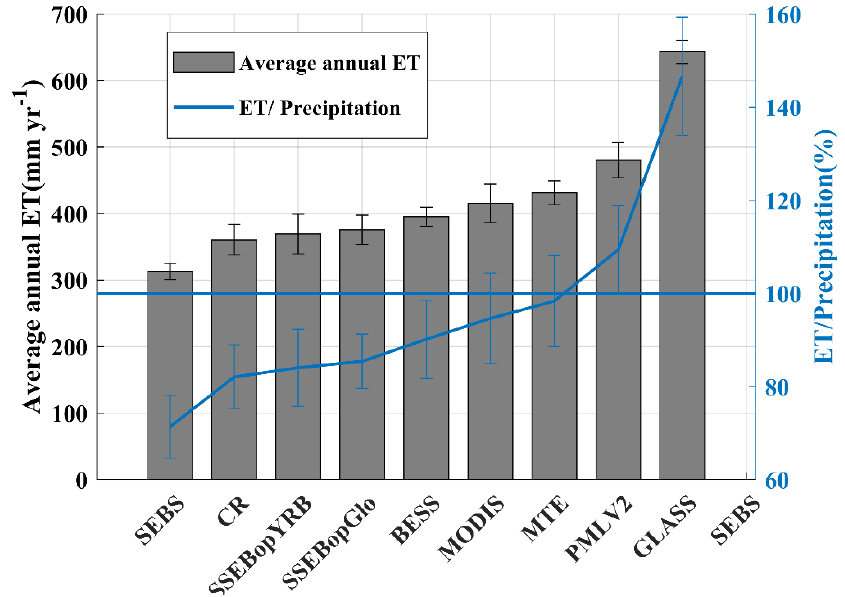
Figure 5. Mean annual ET values for nine ET products and the ratios of the mean annual ET to mean annual precipitation (ET/precipitation) during the years 2003–2015 over the YRB.